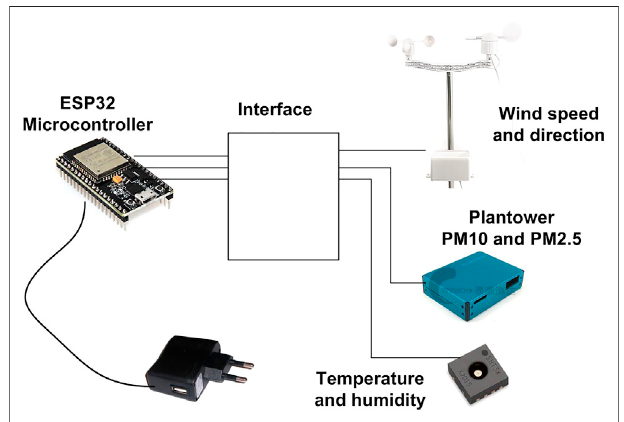
FIGURE 2 | Diagram of the low cost environmental monitoring station.